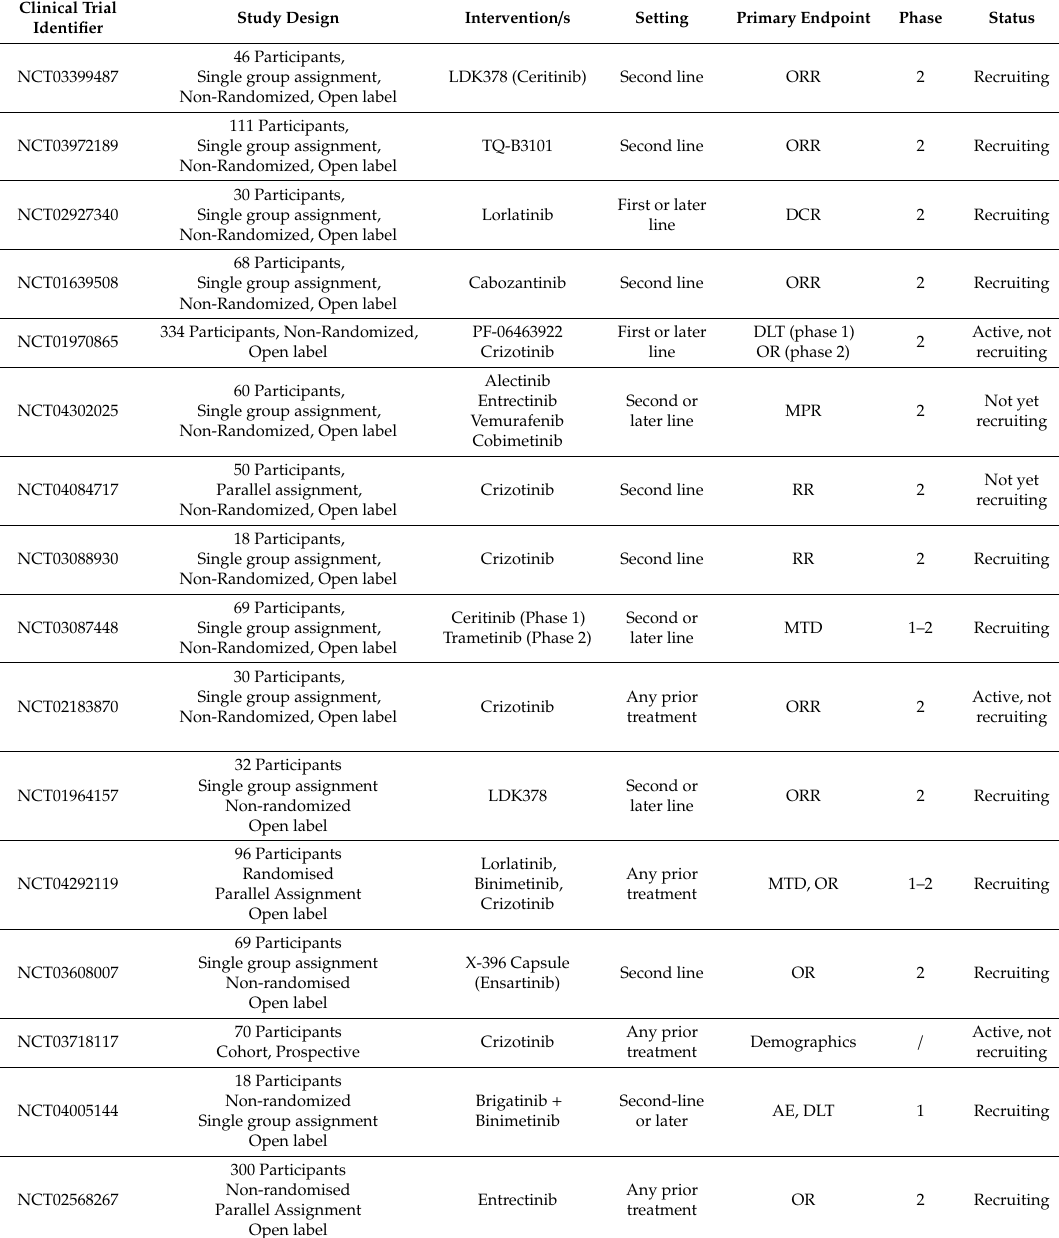
Table 2. Ongoing clinical trials using TKI against ROS1-rearranged lung